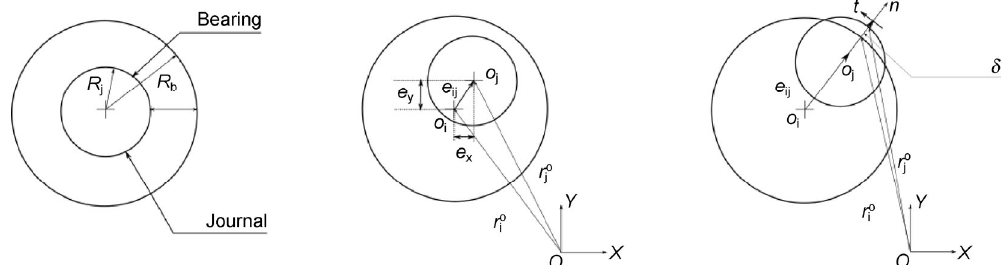
Fig. 15 Representation of the journal bearing with clearance for planar case based on Ref.